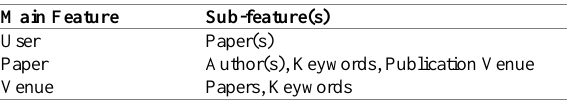
Figure 3. The system